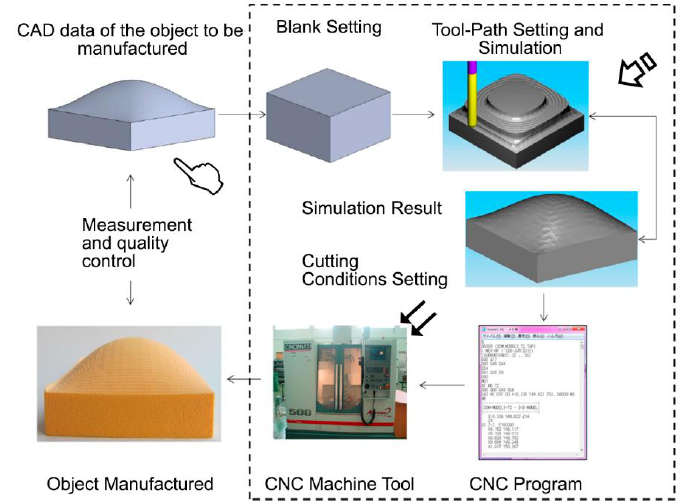
Figure 3. The computer-aided design / computer-aided manufacturing (CAD / CAM) systems are comprised of three main parts: (1) a data acquisition unit, which gathers information from the structure by using scanners, including the defect section and its surrounding and opposing structures, and transforms them to virtual data (pointer); (2) the software required for the data curation and model design (arrow); and (3) a device to manufacture the restoration using specific materials (double arrows) [45,46]. Figure reproduced and adapted from Ullah and Harib (2018) [47]. Copyright MDPI,